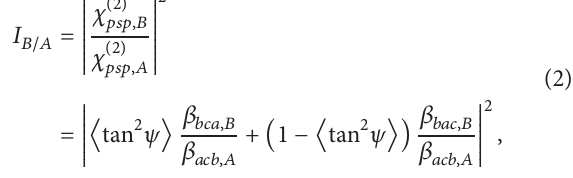
The chiral SFG spectrum of the aggregated hIAPP